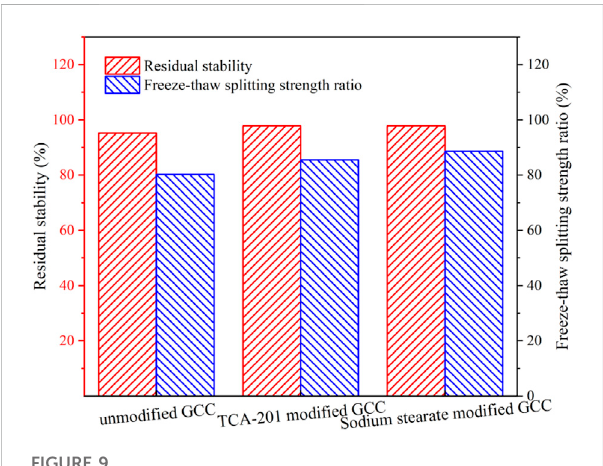
FIGURE 9 The result of immersion Marshall test and freeze-thaw splitting test.